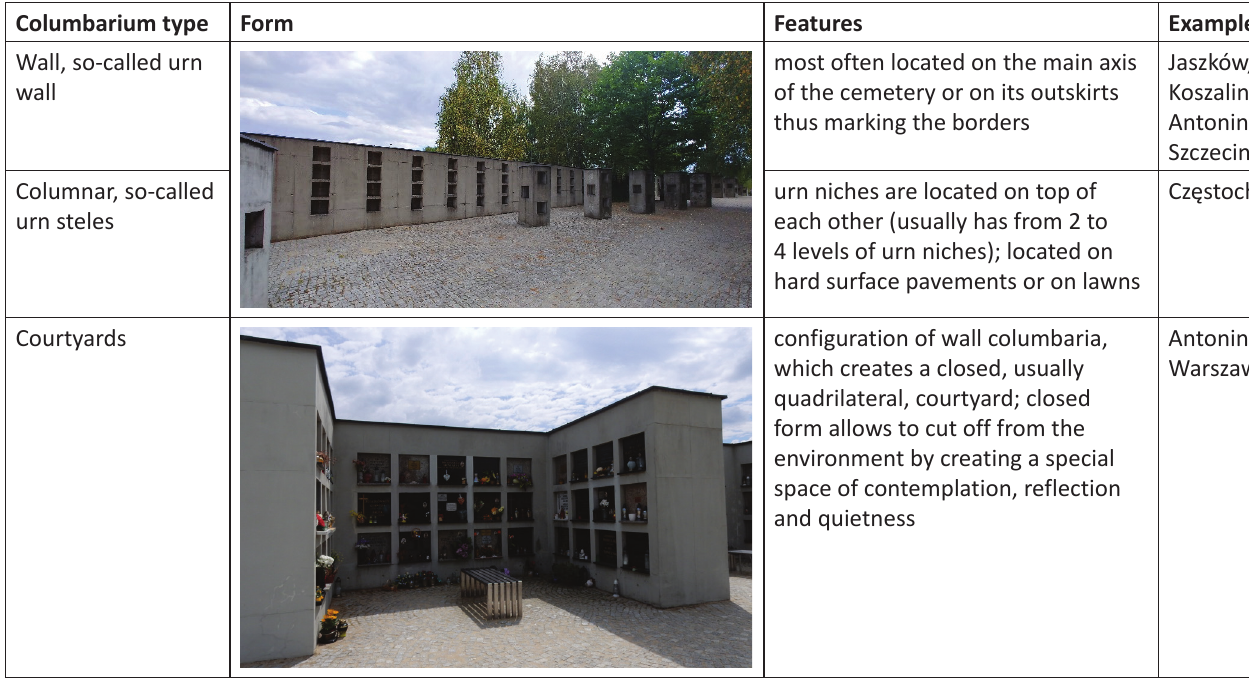
Table 8. List of columbaria types found in Polish funerary landscape. Own